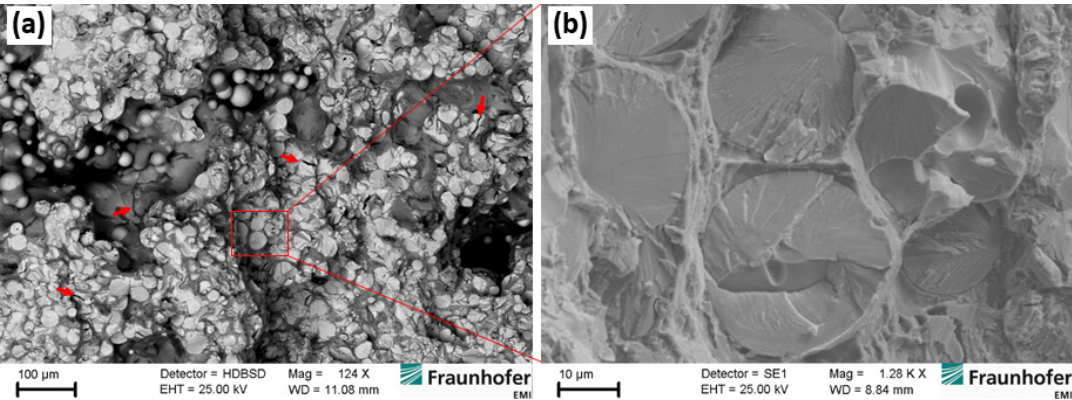
Figure 5. SEM images of a failure surface of a tensile test specimen. ( a) Backscatter image showing tungsten particles (bright) and matrix phase (dark); ( b ) Magnification of the left image. Cleavage of the tungsten particles thoroughly embedded in the steel matrix can be observed.